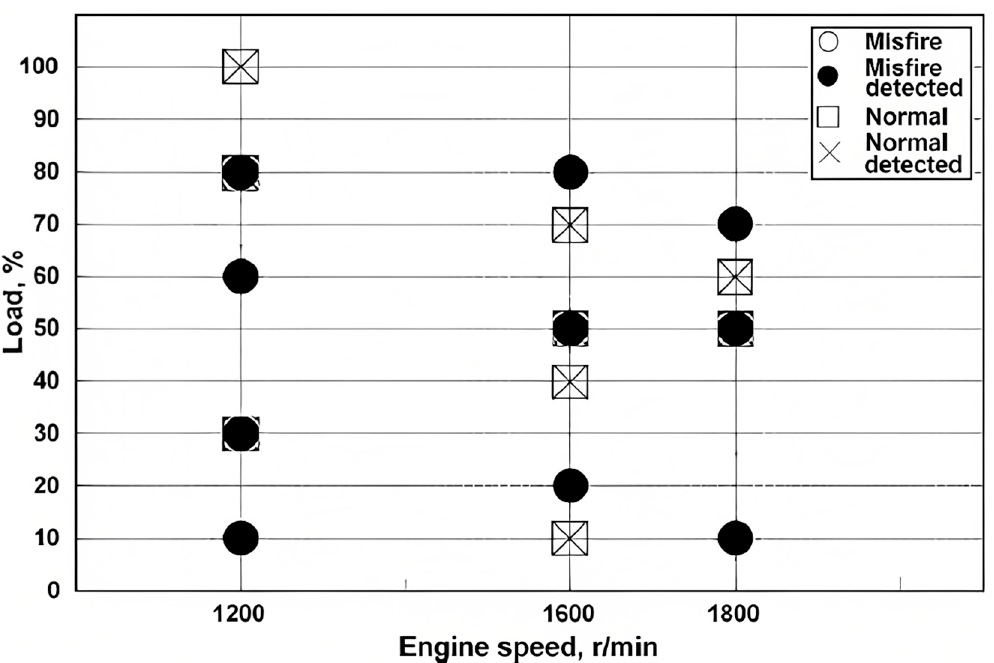
Figure 19. The 100% accuracy final misfire detection after including transient speed information.